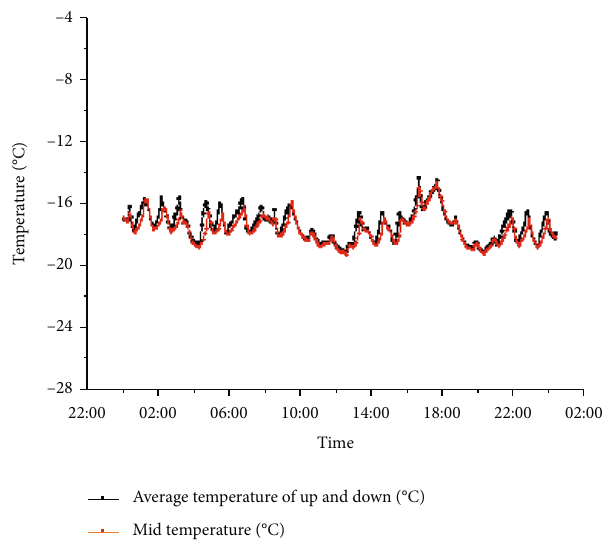
Figure 5: Average temperature and midtemperature of measuring points at vertical position 5.